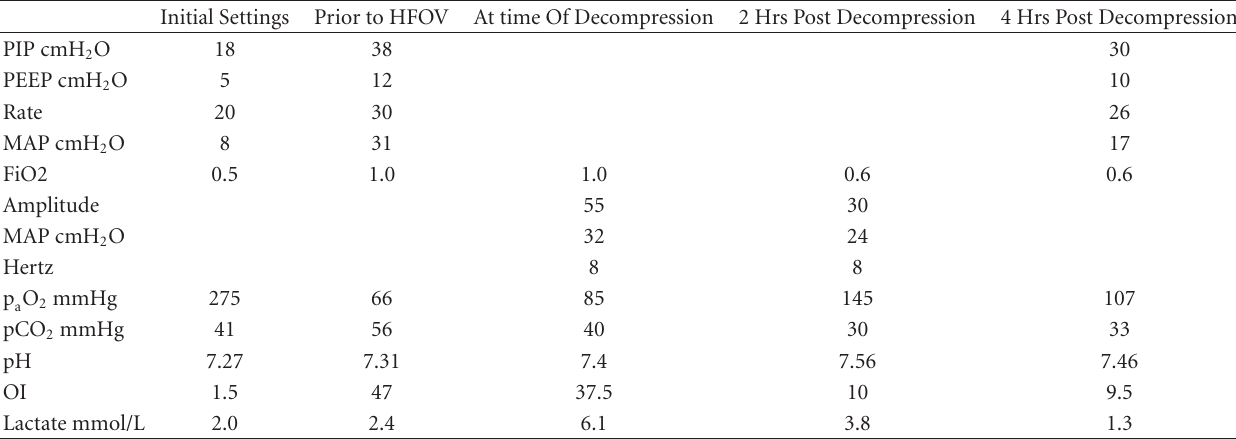
Table 1: Ventilation parameters before and after abdominal